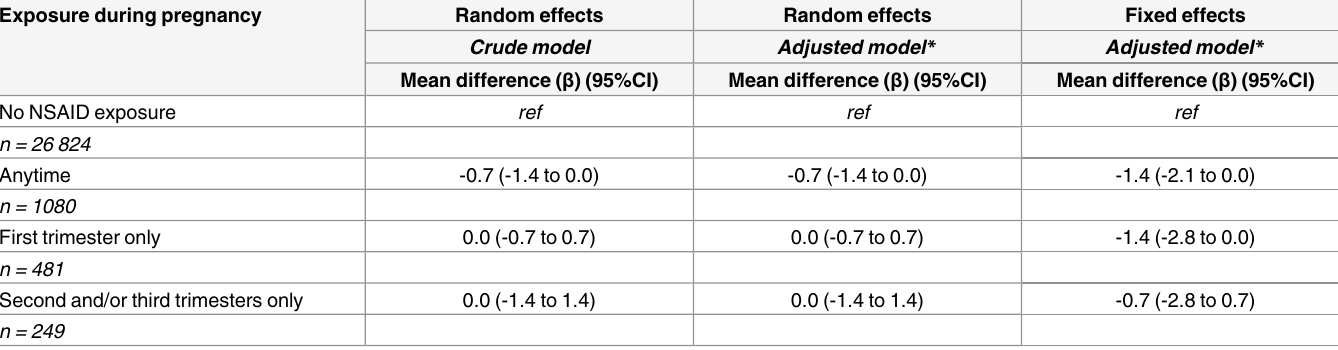
Table 5. Associations of ibuprofen with gestational age according to timing of exposure. All values are given in days. Exposure during pregnancy